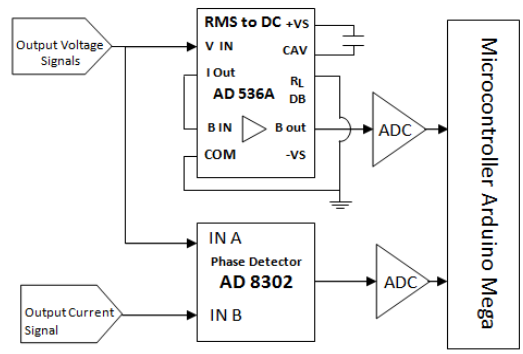
Figure 7. Measurement scheme of voltage and phase difference.